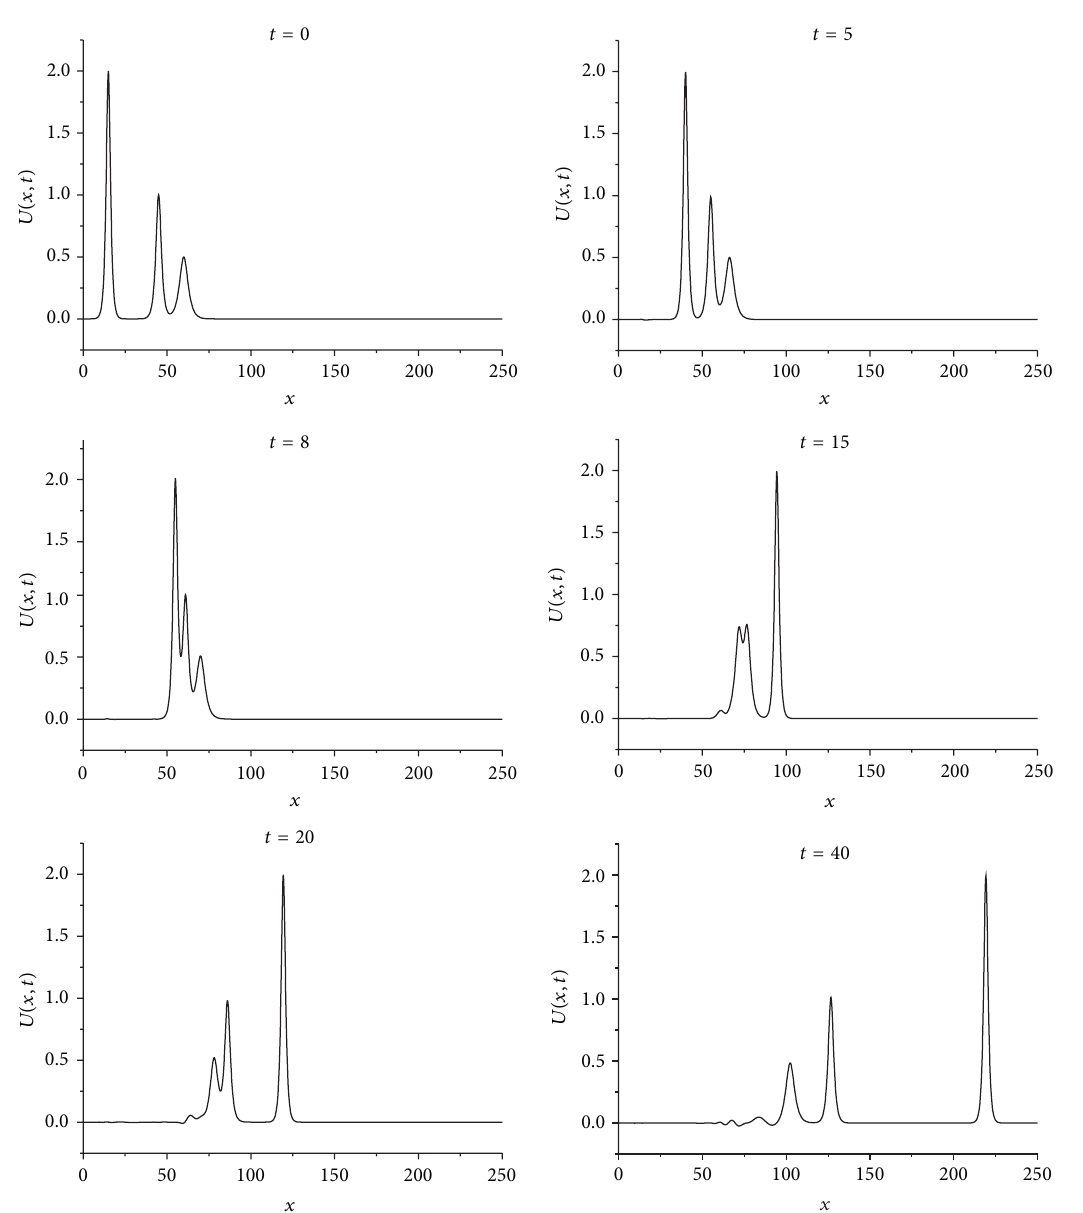
Figure 5: Interaction of three solitary waves with 𝑡 = 0, 5,8, 15, 20, and 40